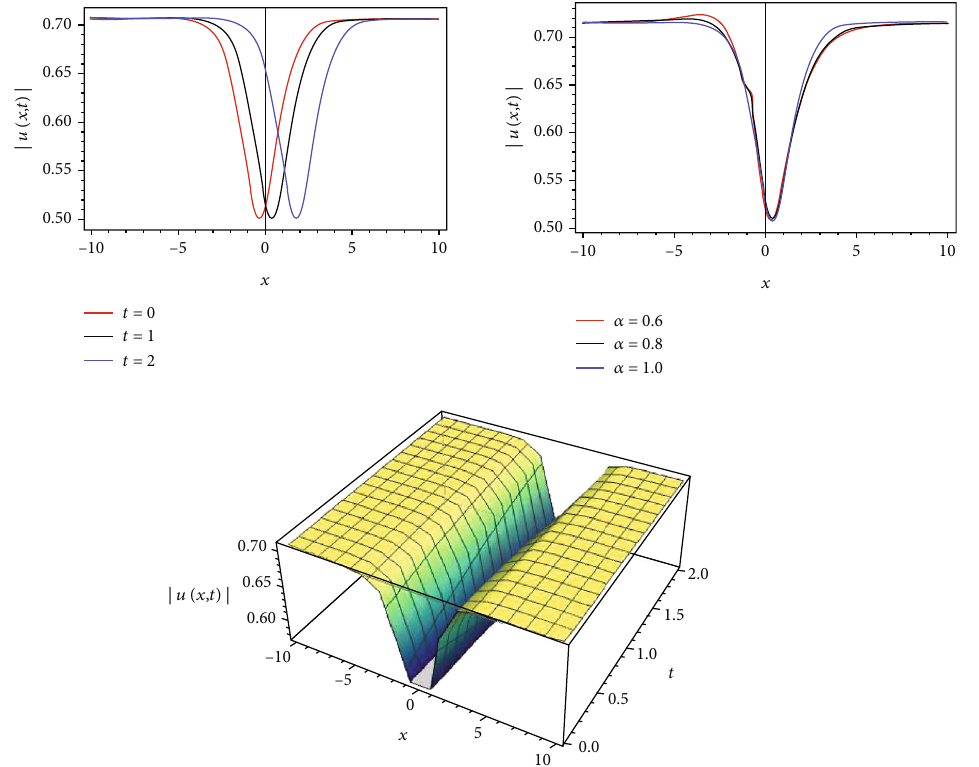
Figure 8: 2D and 3D graphics of Case 1 for hyperbolic traveling wave solution (55) at f α = 0 : 6, k = 0 : 7, q = 1, s = 1, C = − 1, c = 0 : 5